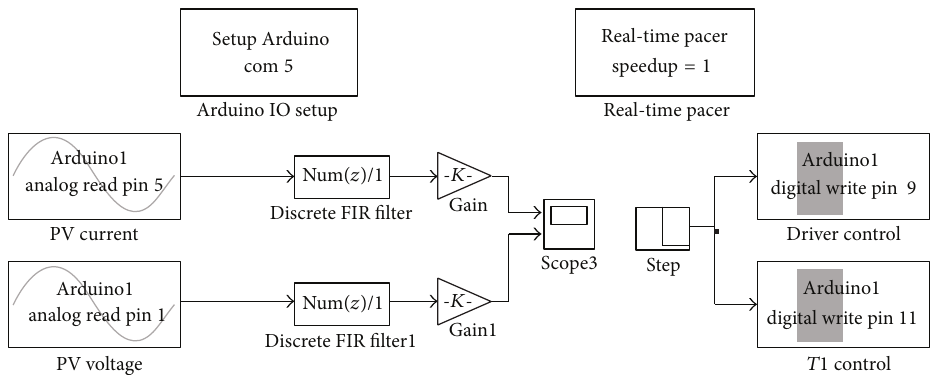
Figure 5: Matlab Simulink interface for control and data acquisition via chipKIT